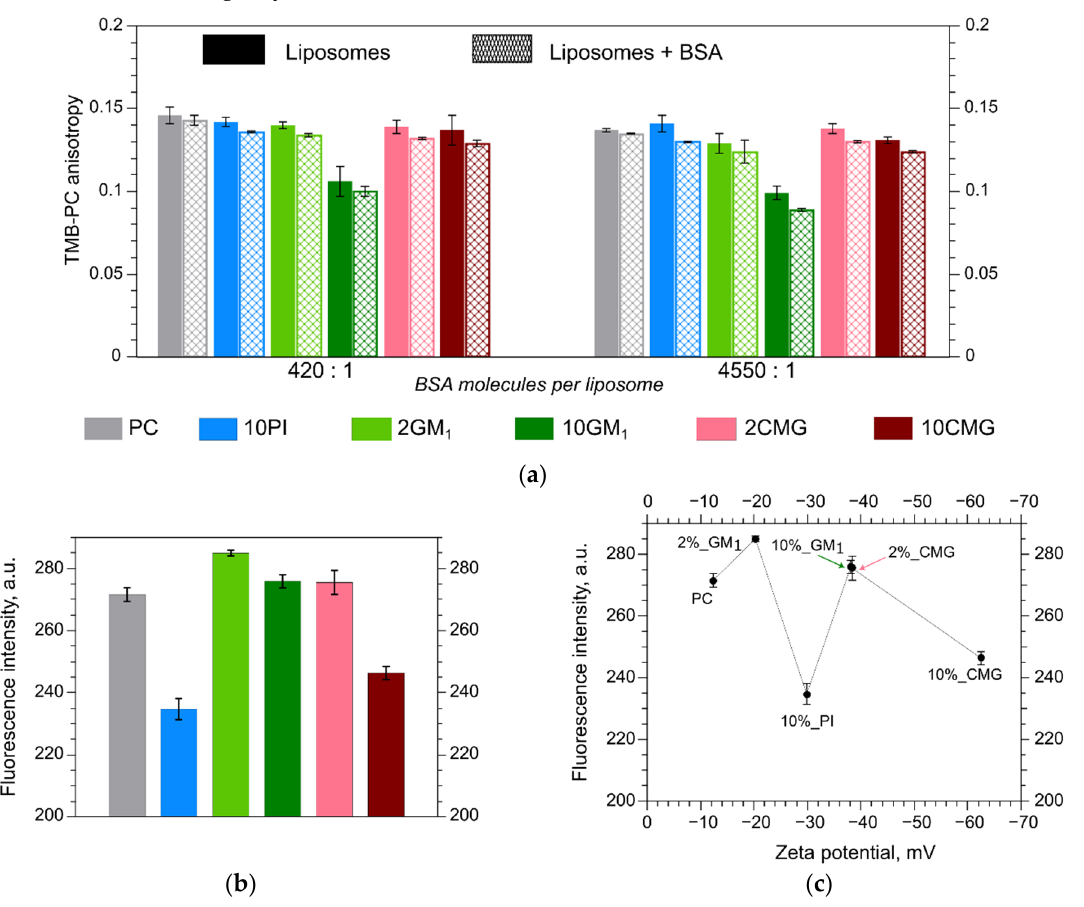
Figure 3. ( a ) TMB-PC anisotropy in liposomes alone and in the presence of albumin; ( b ) ANS fluorescence in the presence of liposomes; ( c ) ANS fluorescence intensity–liposome zeta potential dependence. Mean ± SD ( n = 3) are presented.